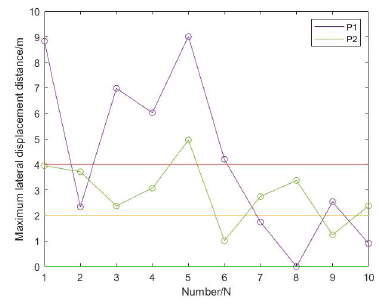
Figure 11. Maximum lateral displacement distance.